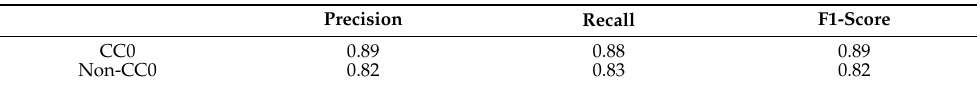
Table A5. XGBoost supervised classification machine learning model that predicts complete cytore- duction using the new intraoperative score: precision, recall, and F1-score for both classes, namely,